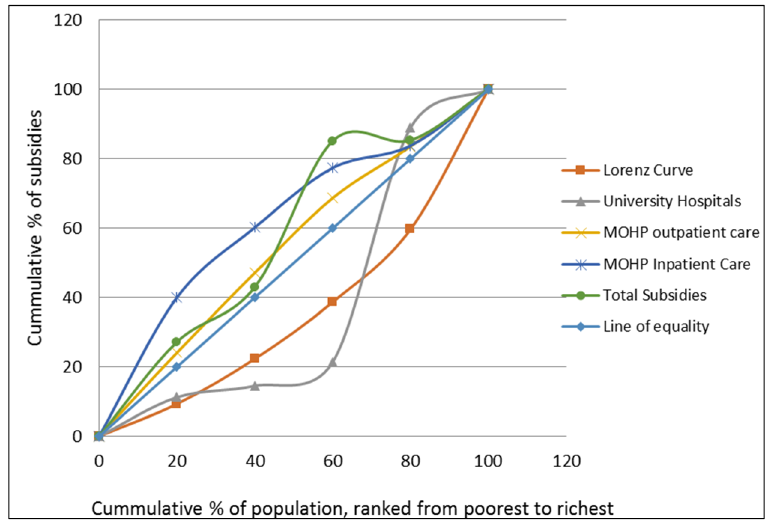
Figure 4. Concentration curves for health sector